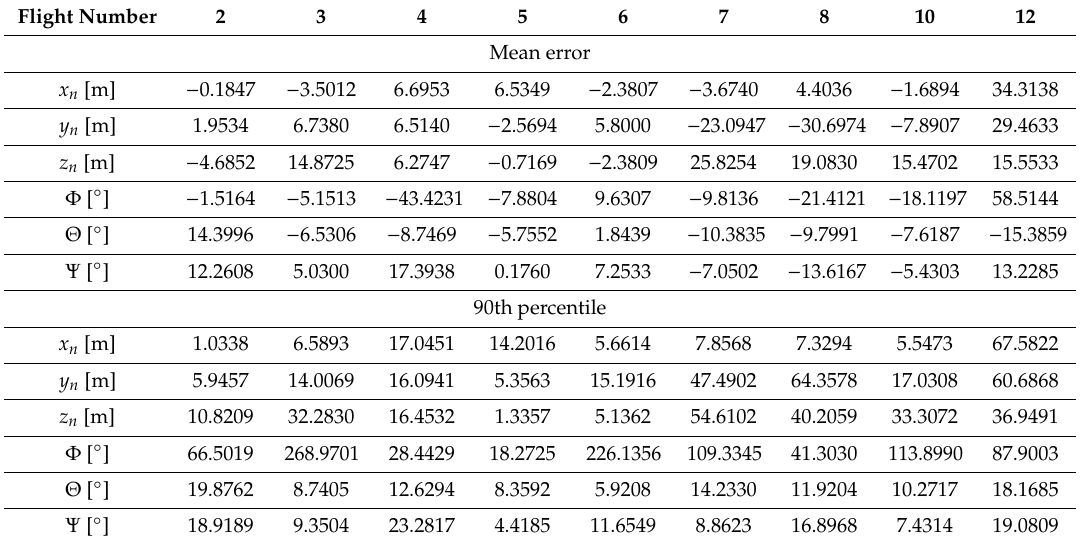
Table 7. Mean error and 90th percentile (from main motor ignition to parachute